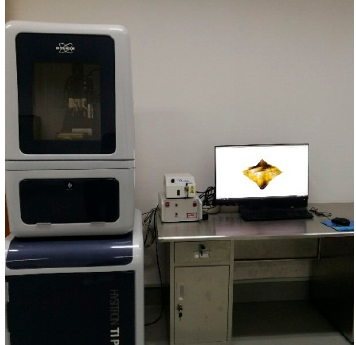
Figure 5. The instrument of nanoindentation.